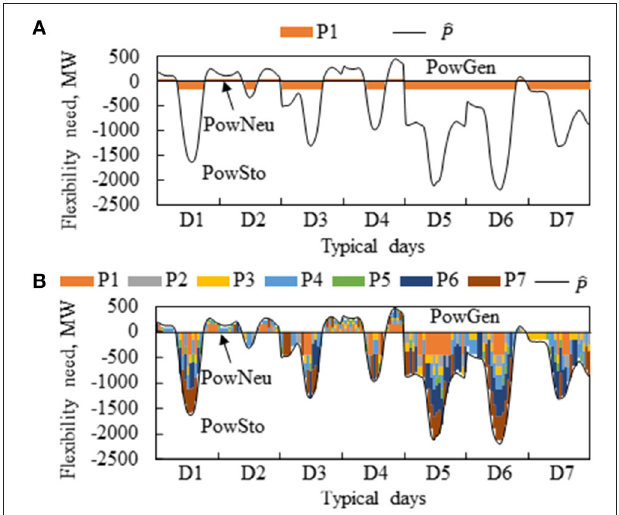
FIGURE 7 | Dispatch of the plant deployed to cope with the flexibility needs in SUD-S2: (A) single FICFB-based plant, (B) seven EFG-based plants.